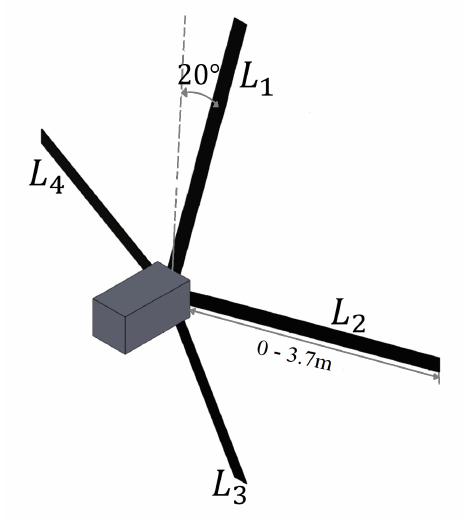
Figure 1. Drag Maneuvering Device schematic.